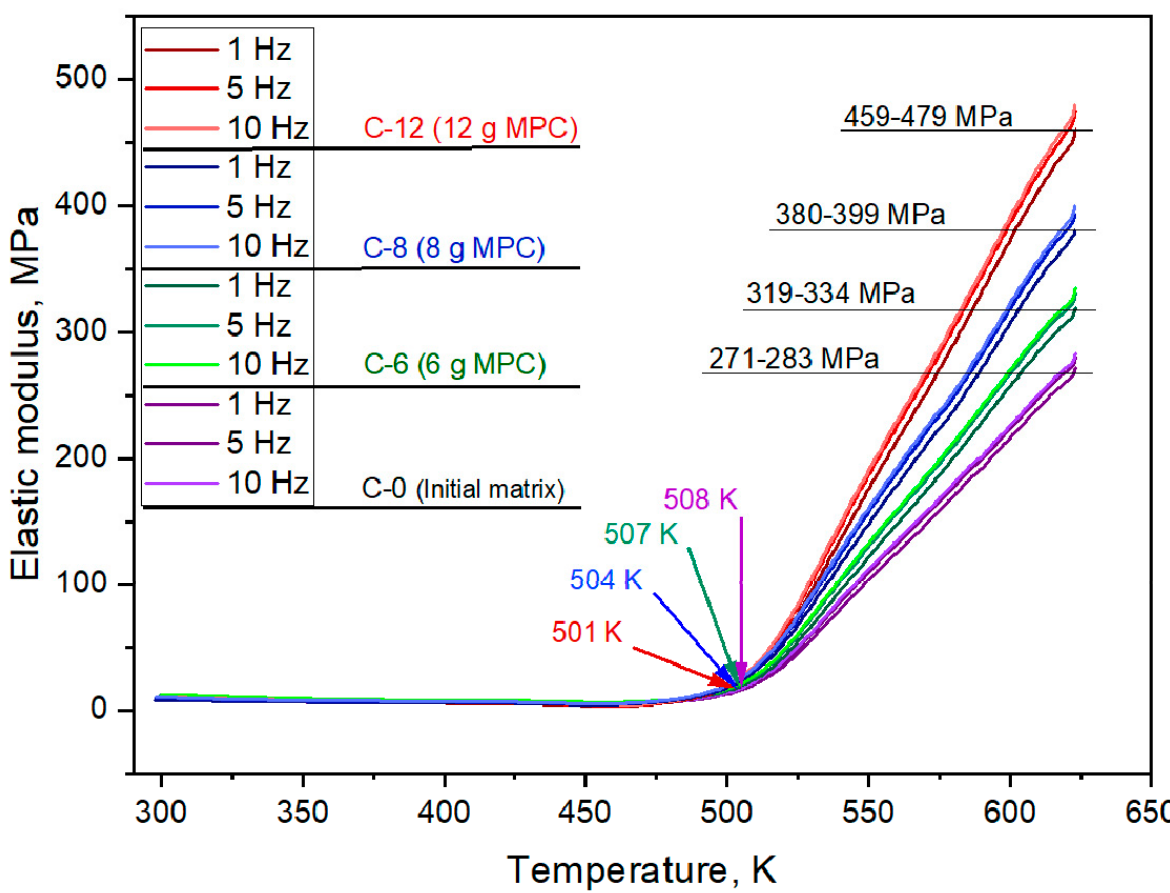
Figure 5. Dependence of the elastic modulus on temperature E’(T) obtained at various frequencies (1, 5, and 10 Hz) and for differently filled composites.